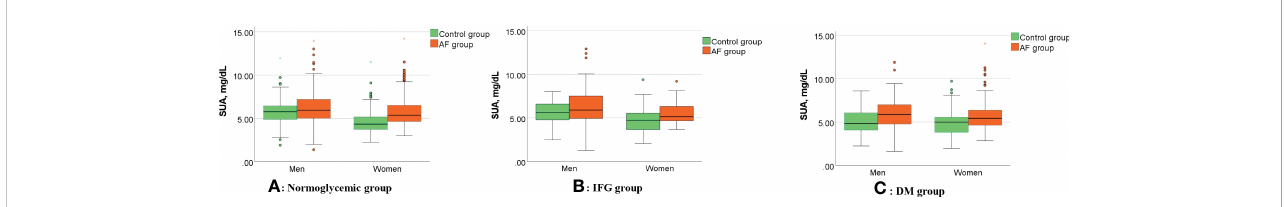
FIGURE 1 Gender differences in SUA levels between AF patients and controls under different FBG metabolic patterns. (A – C) Compared with controls, SUA levels of the AF patients were signi fi cantly higher in the men (all p<0.05) and women (all p<0.05) in different FBG patterns. AF, atrial fi brillation; SUA, serum uric acid; IFG, impaired fasting glucose; DM, diabetes mellitus.